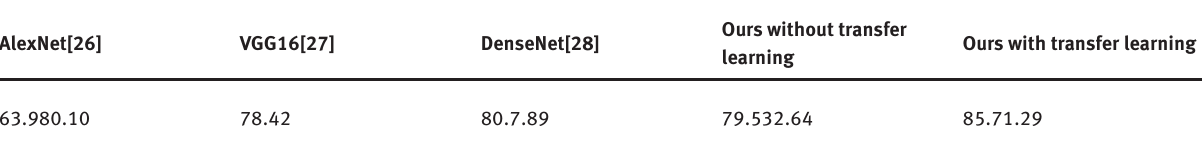
Table 5: Accuracy (%) on our dataset over 5 runs